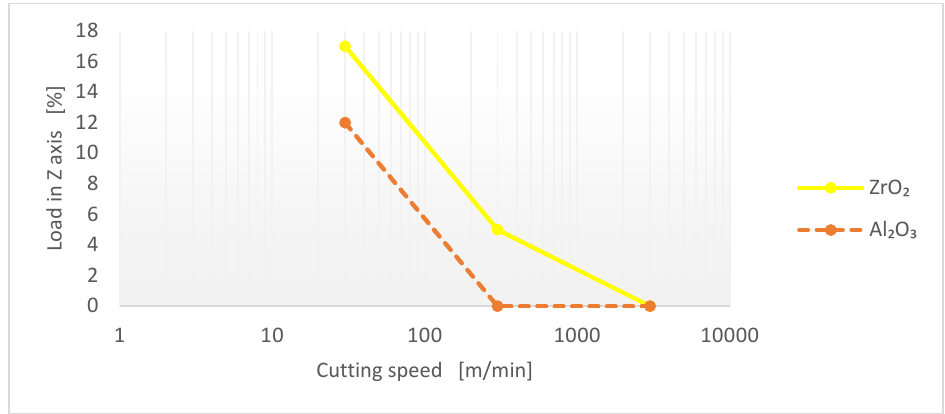
Figure 2. Influence of cutting speed on load in the Z axis.